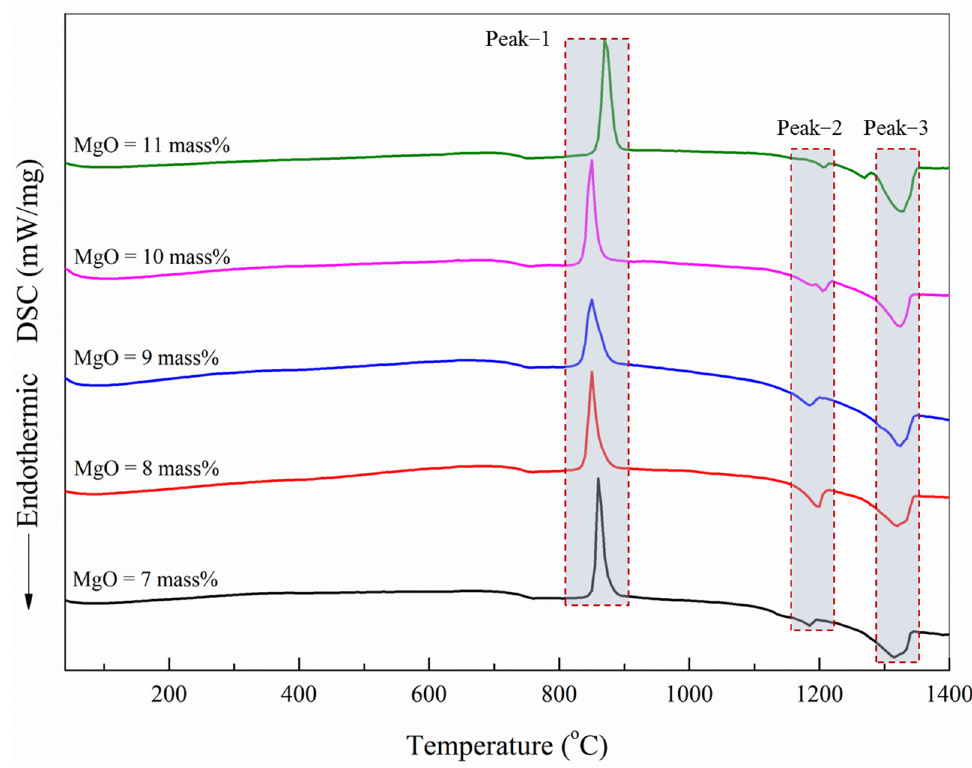
Figure 2. DSC curves of the water-quenched BF slag with different contents of MgO.